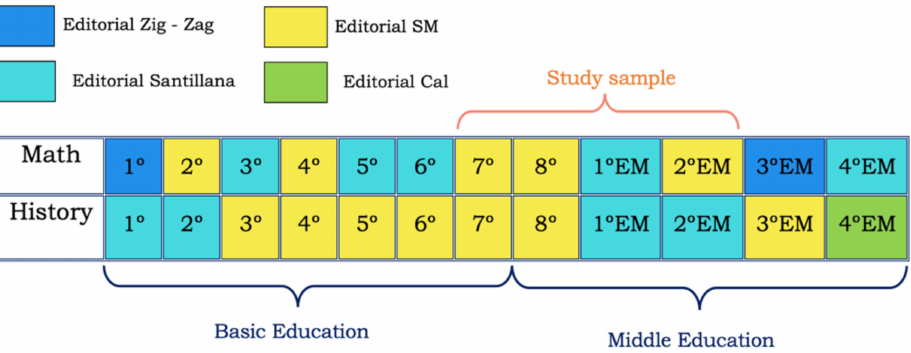
Figure 1. Representation of the editorials in charge of the edition of textbooks in Chile for each educational level (Source: Prepared by the